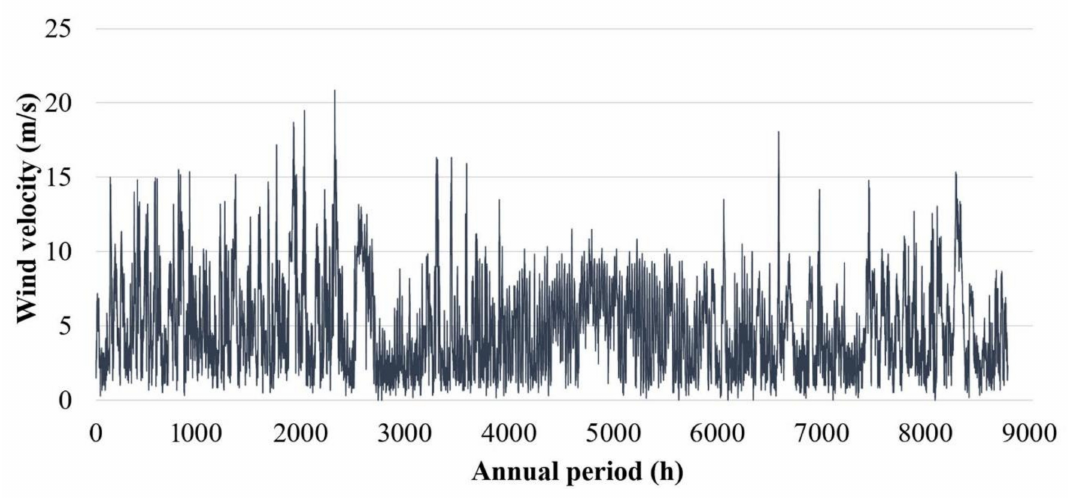
Figure 10. Annual wind velocity fluctuation 2.7 km away from the location of the stadium.